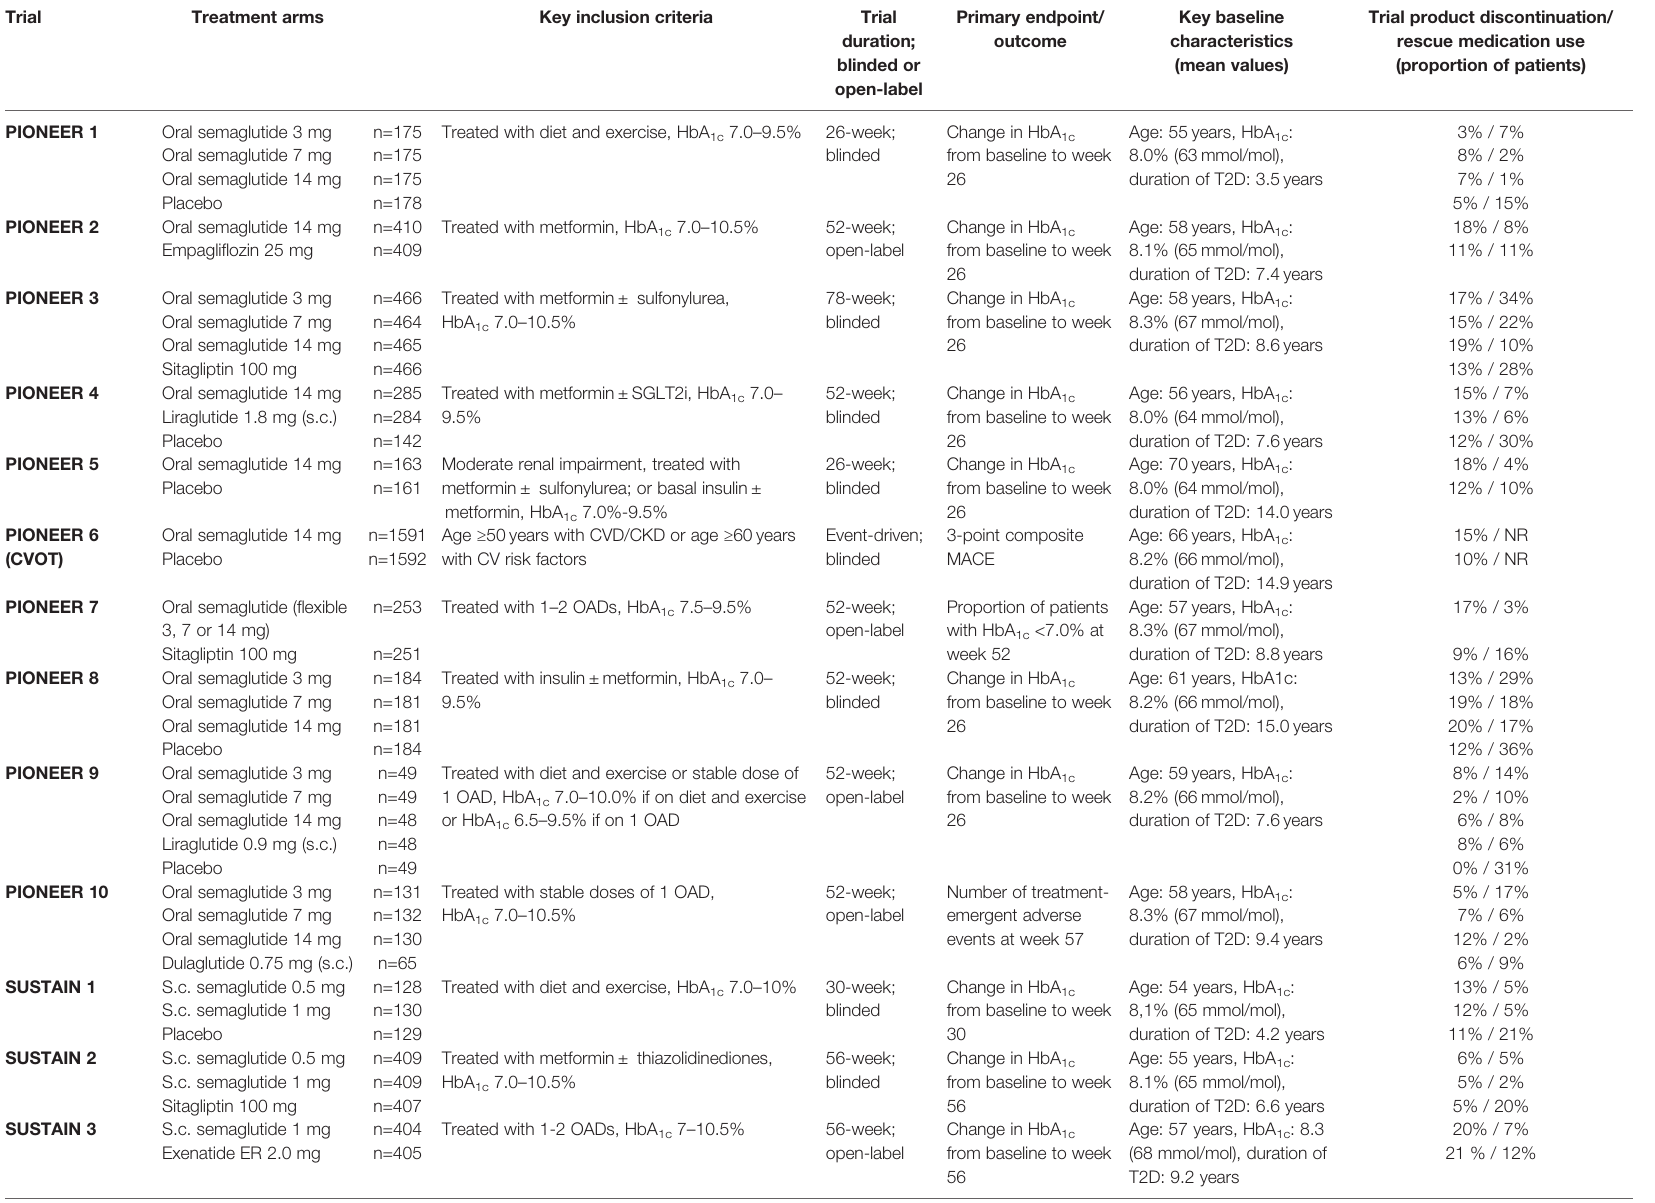
TABLE 1 | Overview of Phase 3 studies of oral semaglutide (PIONEER) and subcutaneous semaglutide (SUSTAIN) (10 – 32).